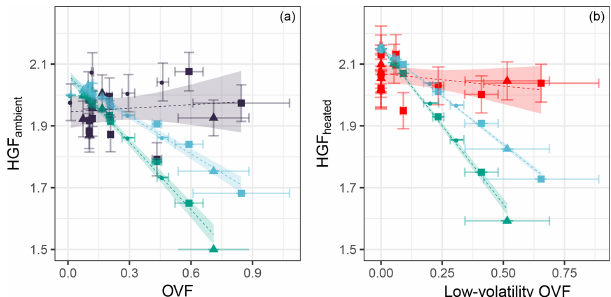
Figure 9. The measured HGF of 50nm diameter SSA at ambient temperature (a) and heated to 255–400 ◦ C (b) as a function of the to- tal OVF and low-volatility OVF, respectively. HGF modelled using ZSR assumption is shown assuming an organic HGF of 1 (green) and an organic HGF of 1.6 (blue) shown alongside measured HGFs (ambient in dark blue, heated in red). Linear fit to the measured and modelled data is indicated by the dashed line; shading represents the 95% confident interval in the linear fit.